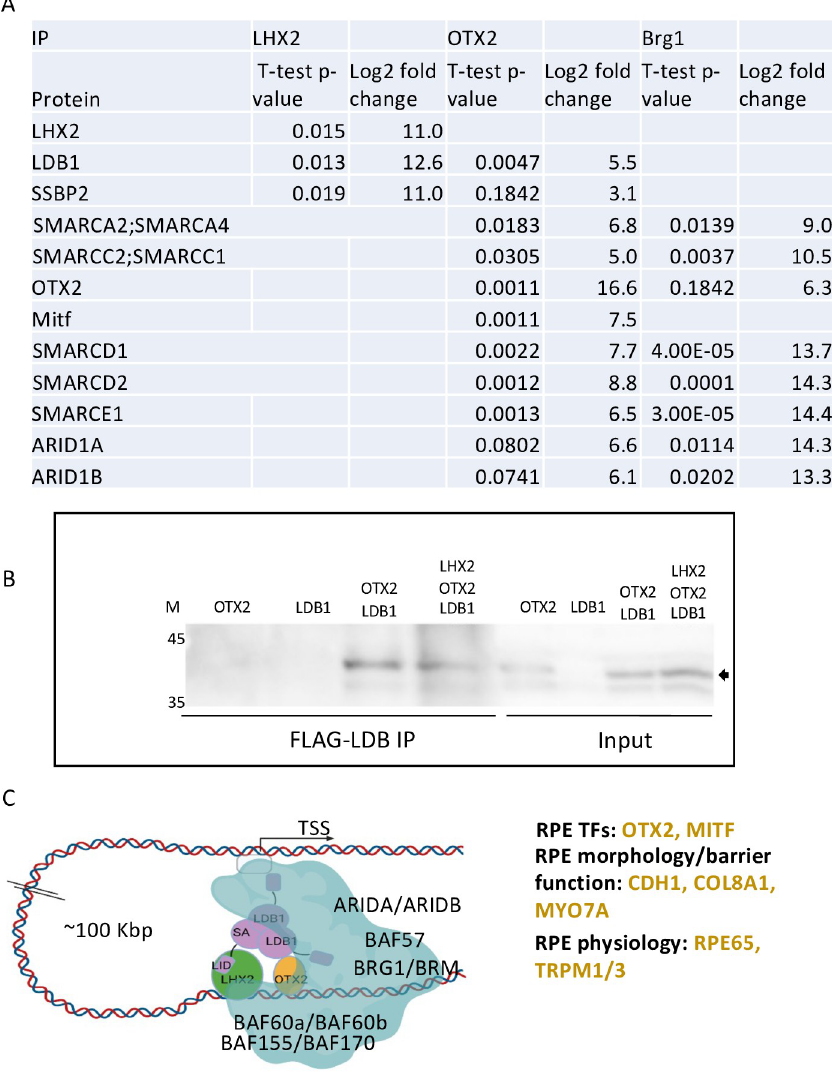
Fig 5. The LHX2 and OTX2 co-factors in human RPE. (A) Table summarizing the statistical analysis ( t test, two- tailed, paired) and the Log2 fold change in proteins bound by LHX2, OTX2, and BRG1 compared to proteins bound by nonspecific IgG based on immunoprecipitation followed by mass spectrometry (IP-MS) analyses. (B) 293T cells overexpressing OTX2, LDB1, LHX2 in the indicated combinations (Input), were subjected to IP with Flag antibodies followed by western blot analyses and immunolabeling with OTX2 antibody, the arrow points to OTX2. S1 Raw image.). (C) Illustration (using Biorander) of the identified co-factors and key downstream targets in hES-RPE. IP, immunoprecipitation; Mitf, microphthalmia-associated TF; RPE, retinal pigmented epithelium; TF, transcription factor; TSS, transcription start site. noncoding part of the genome, hampering functional interpretation of the GWAS results. To identify causal genes underlying risk for AMD in these genomic loci, Orozco and colleagues recently generated a comprehensive expression-quantitative trait loci (eQTL) resource for the eye [48]. By applying colocalization analysis to GWAS and eQTL signals in each of the 35 AMD-risk loci, that study identified 15 risk loci where, with high confidence, the same genetic variant drives the association with both AMD risk and expression level of the target gene. In these cases of strong colocalization, the eQTL association points to the putative causal AMD-